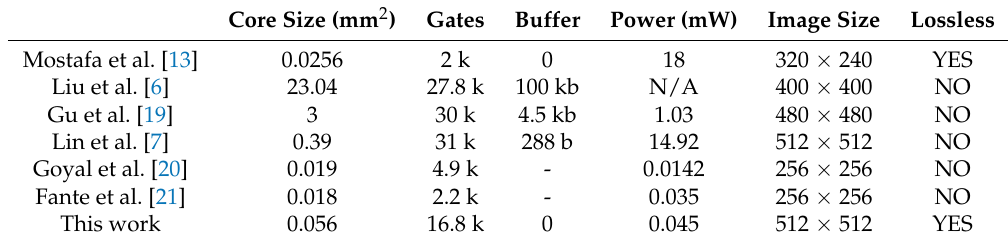
Figure 10. ASIC implementation of the compression algorithm by the use of Cadence software tool set. Table 8. Comparison between proposed compression scheme with others in manner of hardware cost.